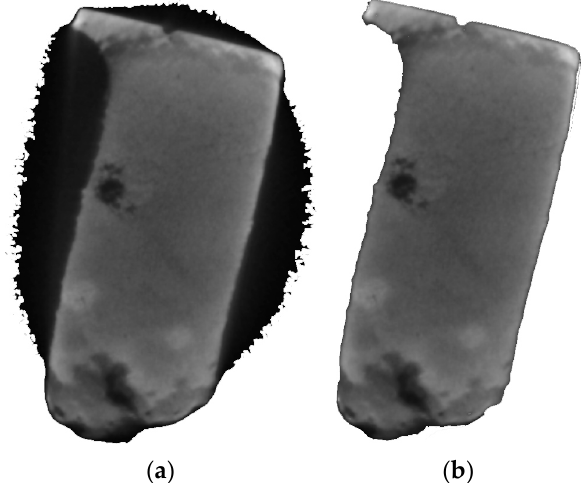
Figure 6. The image of the horizontal projection of the sample after background subtraction ( a ) and the “shadow” subtraction ( b ).